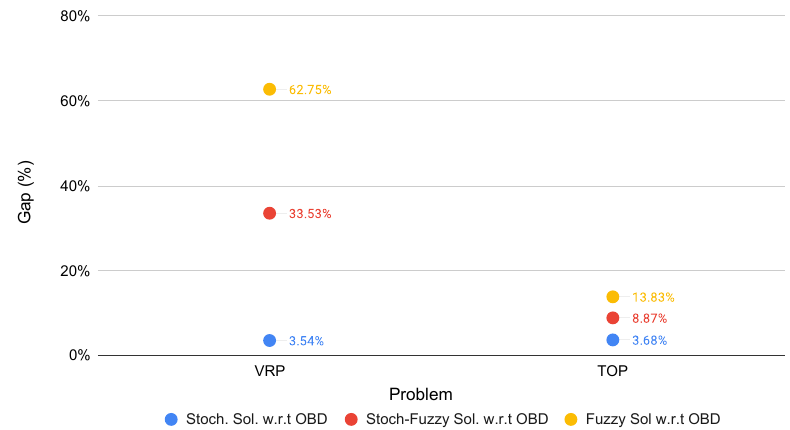
Figure 9. Gaps of different optimisation methods with respect to the OBD